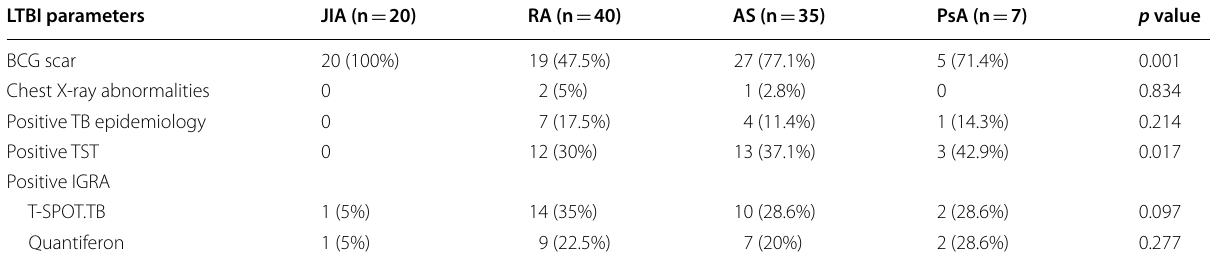
Table 2 Clinical features and test results suggestive of latent tuberculosis infection in patients with chronic inflammatory arthritis after exposure to TNFα inhibitors